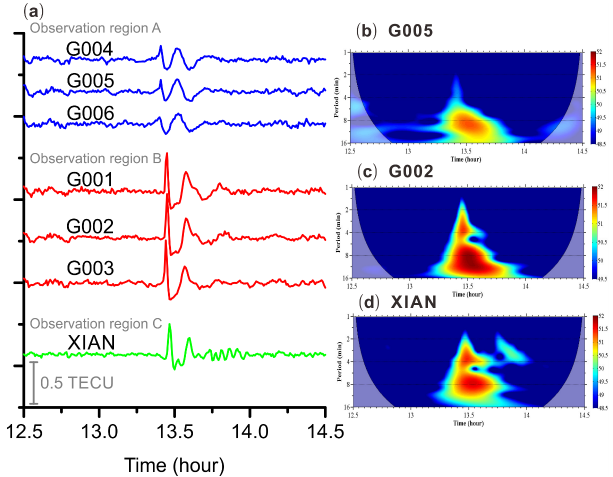
Figure 5. (a) The color curves represent the low frequency part of filtered ionospheric STEC time series for satellite PRN05 of all the seven GPS stations on the day of Tiangong-1 launch (DOY = 272) in three observation regions A, B and C by setting a cutoff period of 12min, the grey curves represent reference curves calculated by least squares polynomial method for the filtered ionospheric STEC time series; (b) the color curves represent the raw ionospheric STEC time series for satellite PRN05 of all the seven GPS stations on the day of Tiangong-1 launch (DOY = 272) in three observation re- gions A, B and C, the grey curves represent also the reference curves calculated by least squares polynomial method for the filtered iono- spheric STEC time